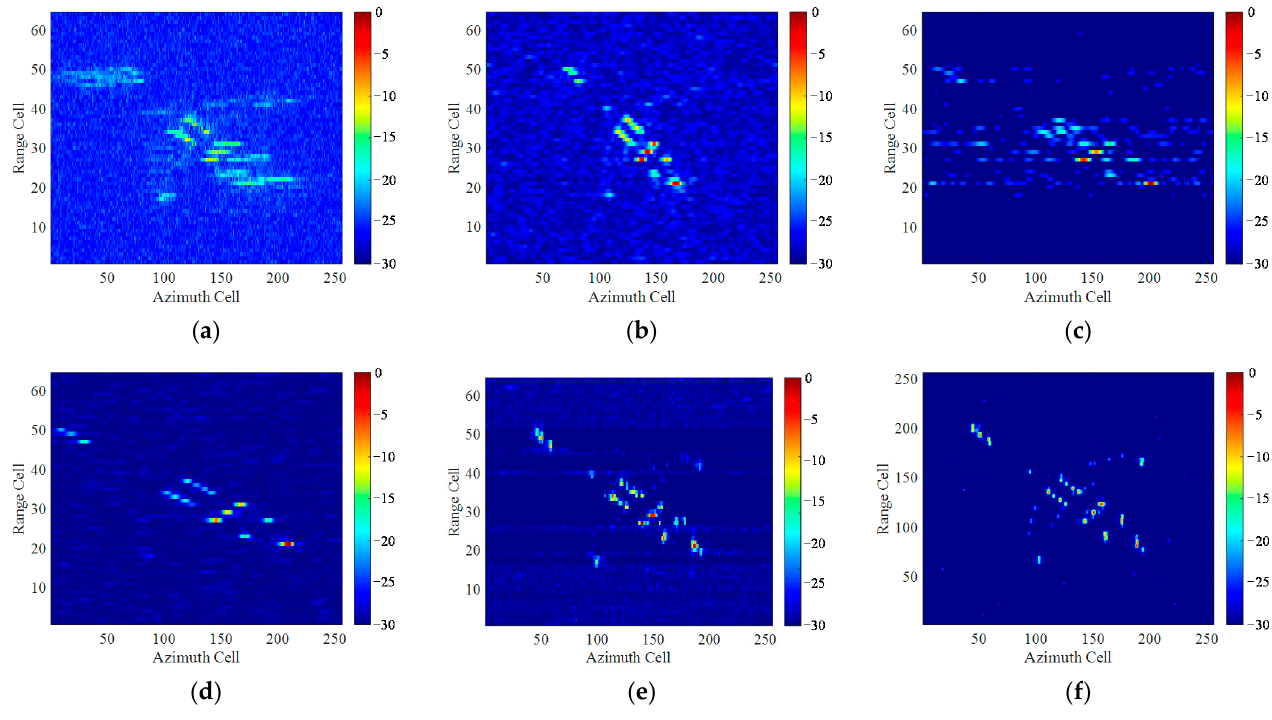
Figure 13. Imaging results of Boeing-727 data with SNR = − 10 dB by different methods: ( a ) RD algorithm; ( b ) STFT algorithm; ( c ) WVD algorithm; ( d ) SPWVD algorithm; ( e ) RWT algorithm; ( f ) the proposed method.